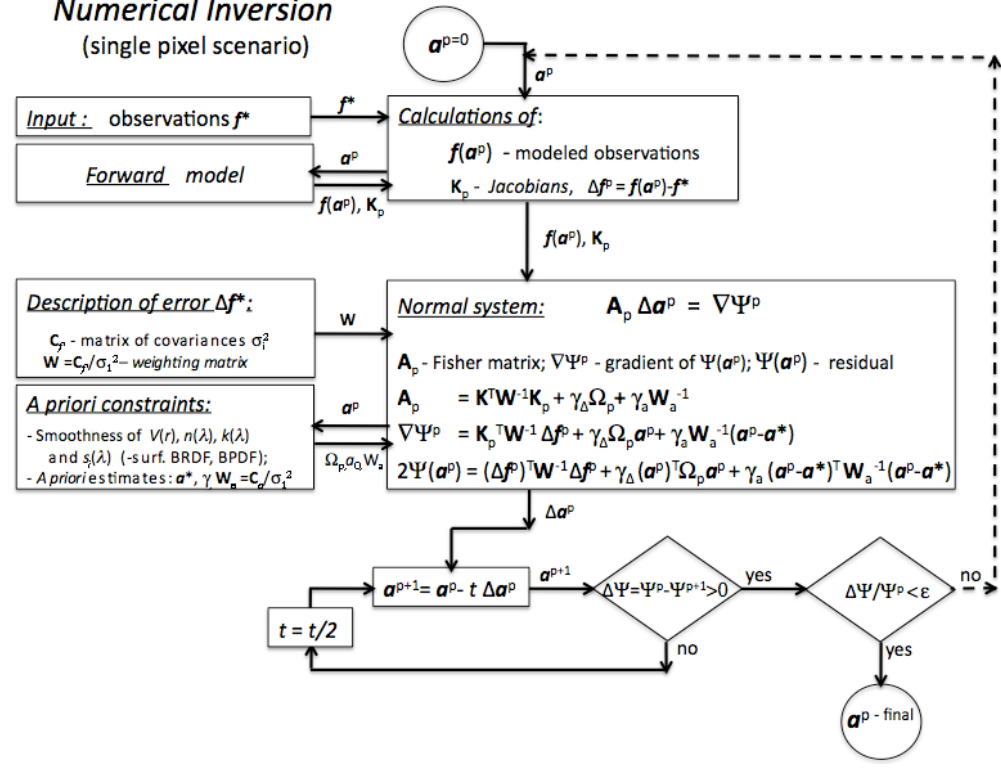
5 Fig. 5. The general structure of the numerical inversion data flow implemented for the retrieval of aerosol over single pixel. (x) denotes most unsmooth real function y i (x) Here y ns i